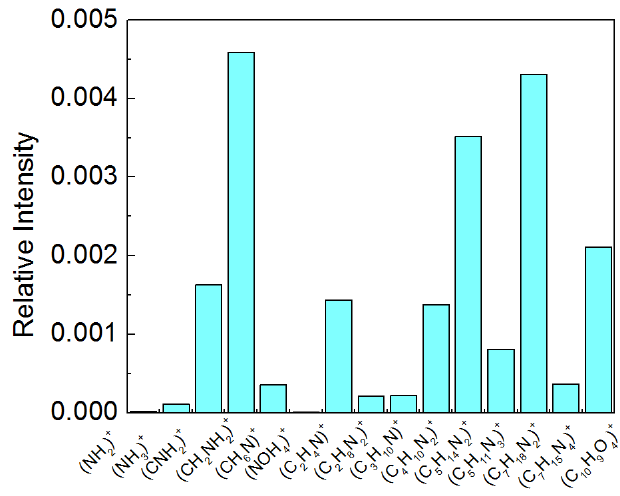
Figure 8. Intensity distribution of the fragments for PET air .